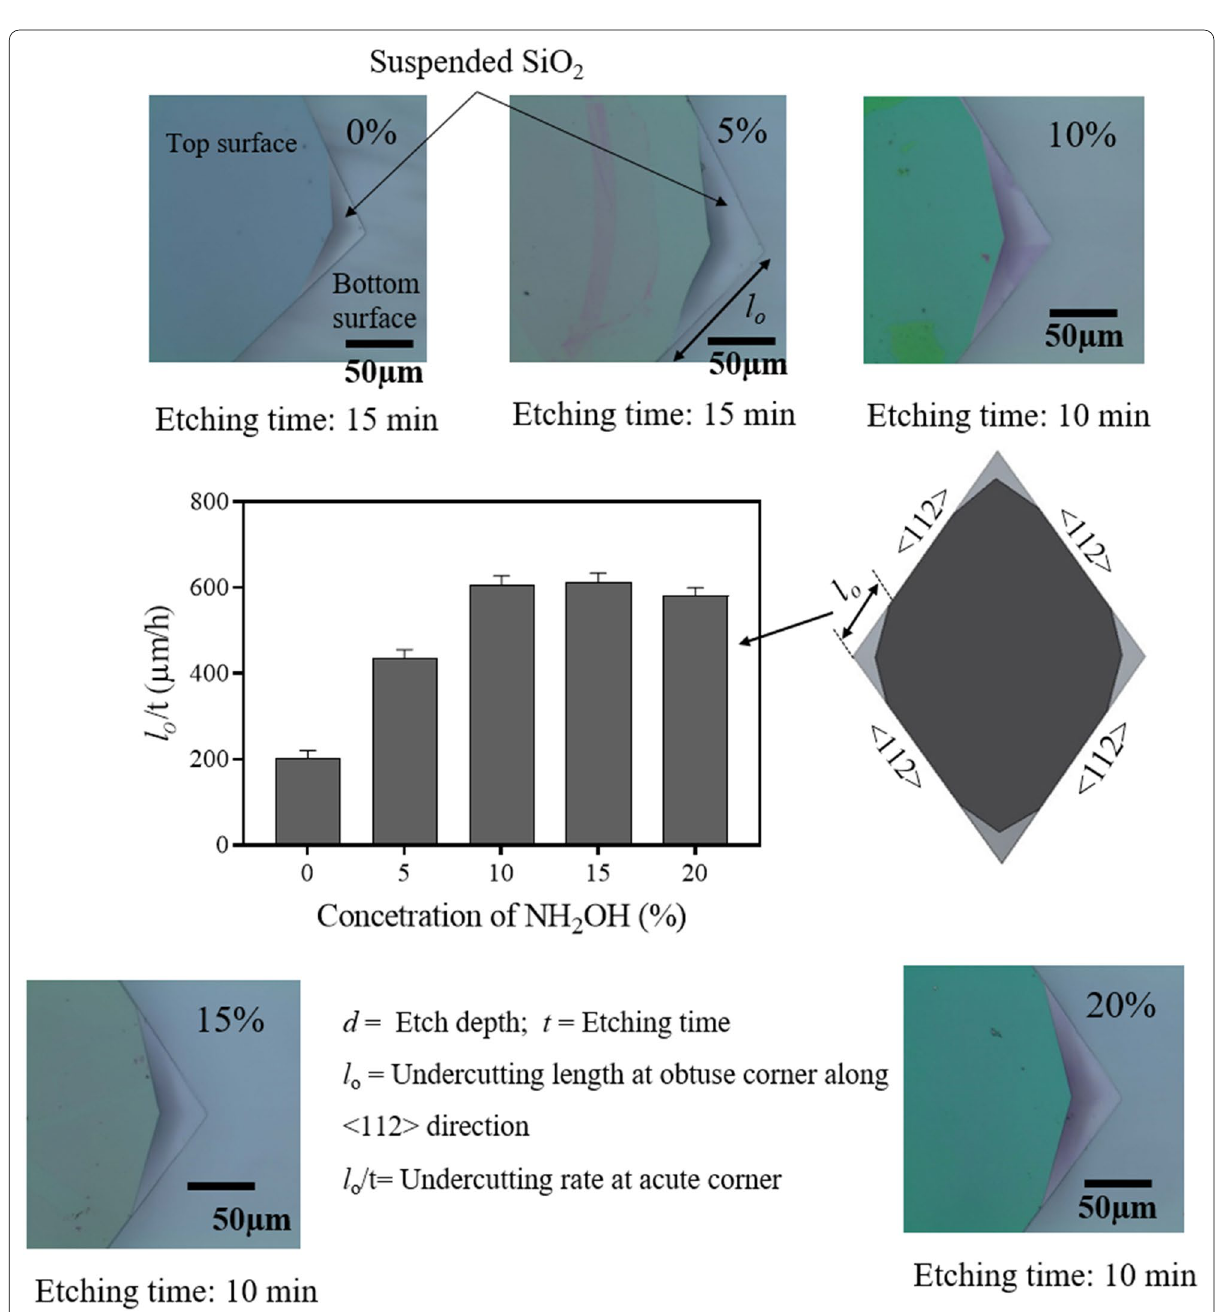
Fig. 57 Undercutting at obtuse corners on Si{110} wafer surface in pure and different concentrations of NH 2 OH-added 5 wt% TMAH at 70